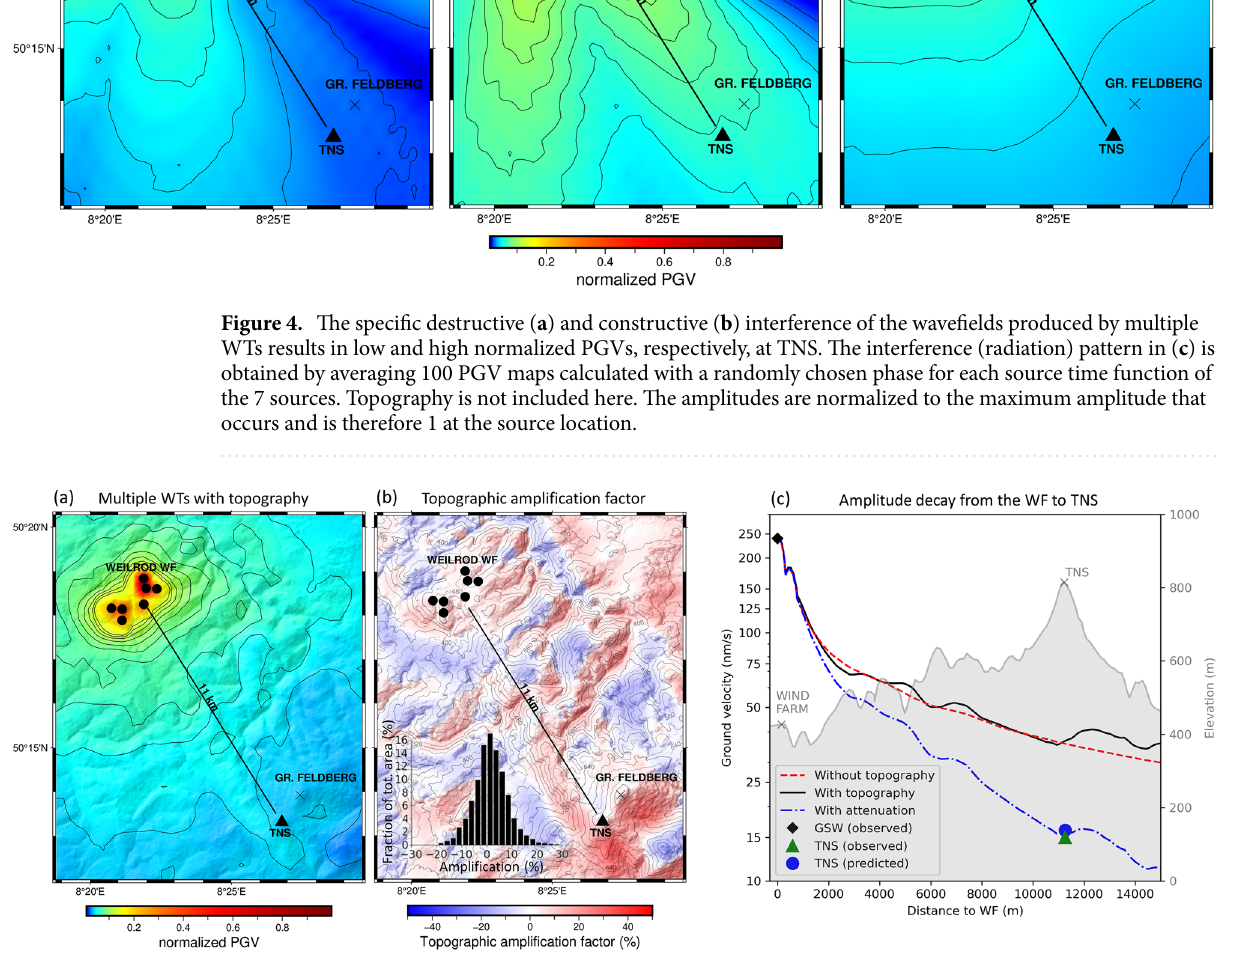
Figure 5. Maps of the average peak ground velocity (PGV) with topography ( a ) and the amplification factor due to topography ( b ) for all seven WTs in the Weilrod WF. On average, the amplification at TNS due to topography is about 9%. The PGVs along a straight line between the centre of the WF (station GSW) and permanent station (TNS) are extracted and calibrated with respect to the measured PGVs at the temporary station (GSW) within the WF ( c ). The measured amplitude at TNS is finally predicted including attenuation in the model. The distribution of the obtained amplification factor in the model domain ranges from − 20 to 30% (histogram in b ). The amplitudes in ( a ) are normalized to the maximum amplitude that occurs and is therefore 1 at the sources. Note: The contour lines in ( b ) are based on the digital elevation model and the left y-axis in ( c ) is